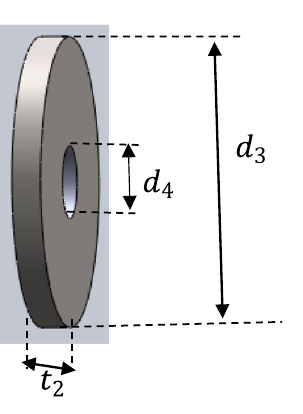
Figure 5. Side cover plates of